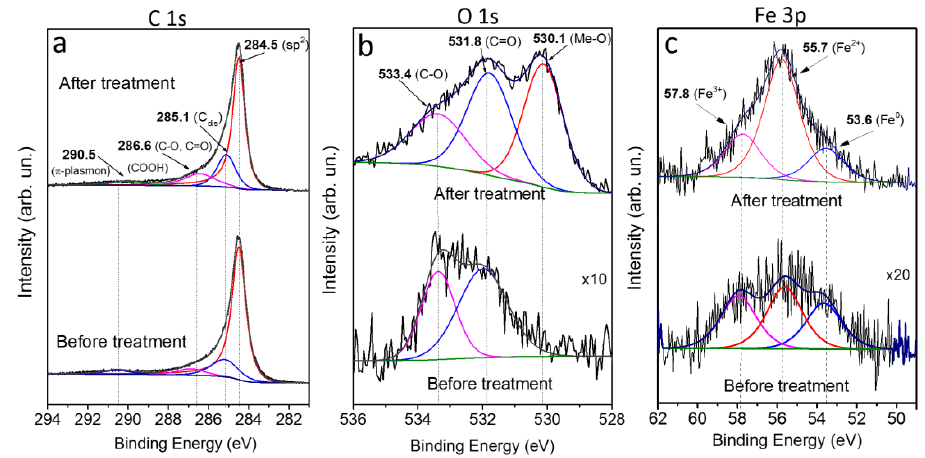
Figure 4. C 1s ( a ), O 1s ( b ), Fe 3p ( c ) XPS spectra of the initial (bottom) and the plasma-treated (top) CNT samples.